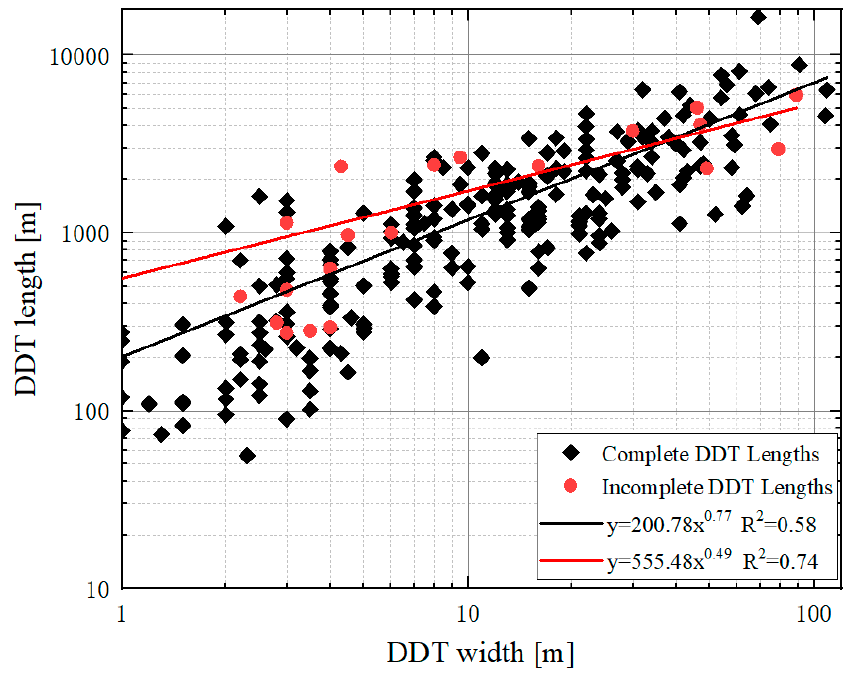
Figure 6. DDT widths versus DDT lengths. The complete DDT lengths are represented by black squares (n = 227). The incomplete DDT lengths are represented by red circles (n = 21). L = 200.78 W 0.77 (1)